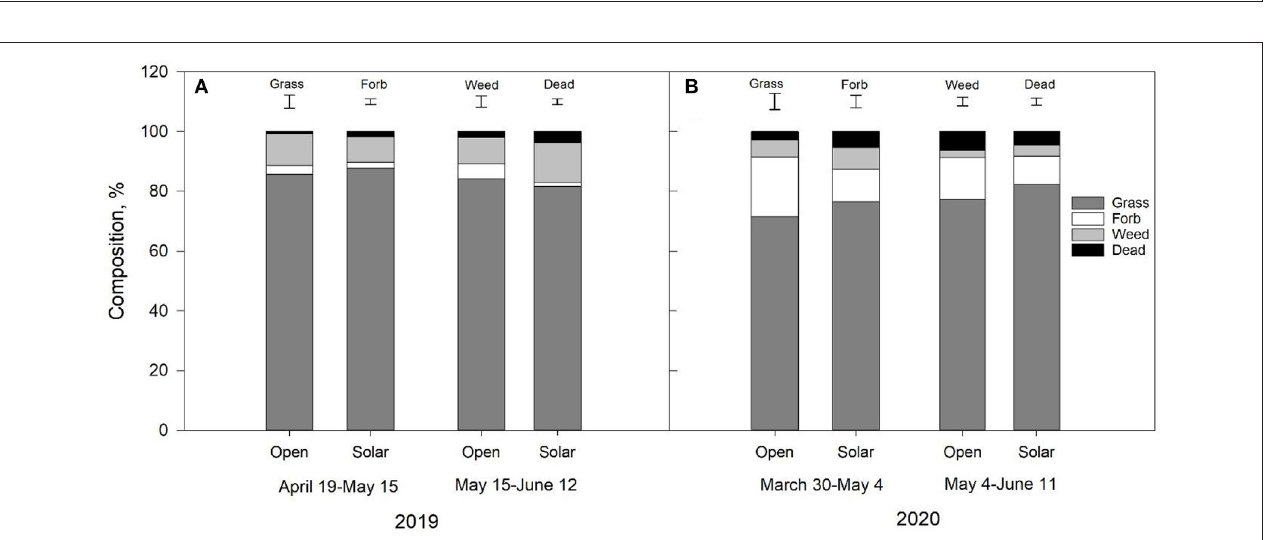
FIGURE 4 | Botanical composition of pasture on offer (%) in open and solar pastures in 2019 (A) and 2020 (B) . Bars represent SEM.